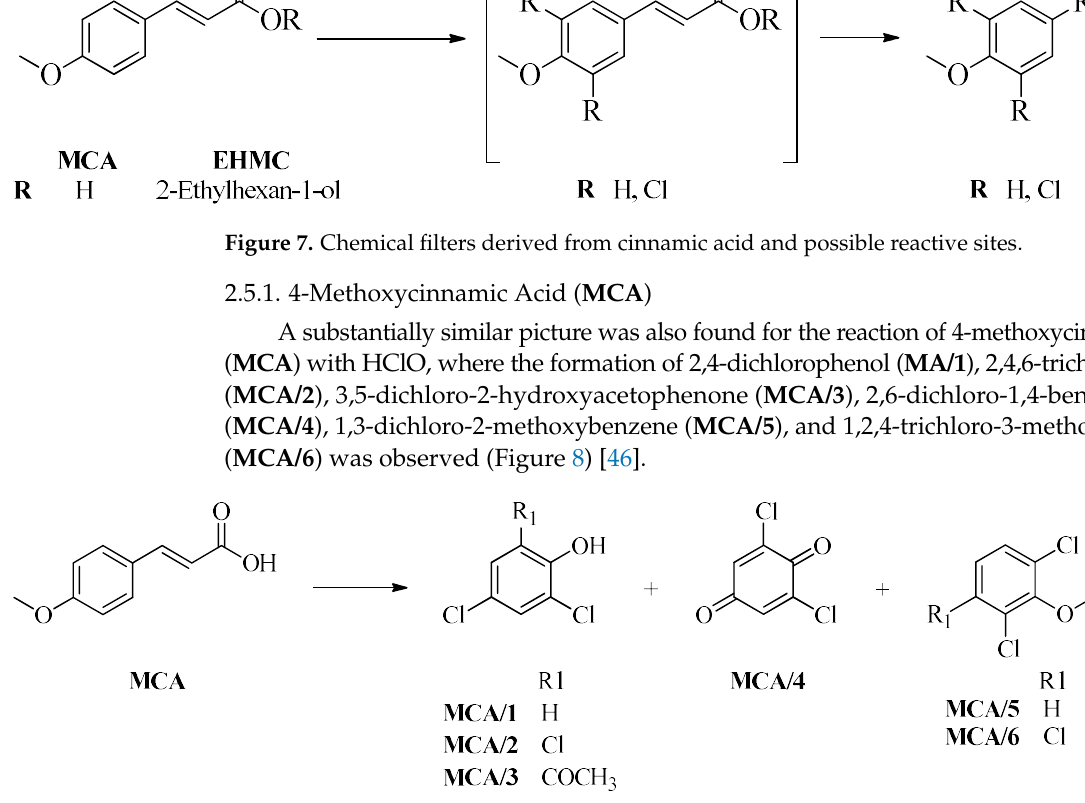
Figure 8. Disinfection by-products from MCA chlorination.